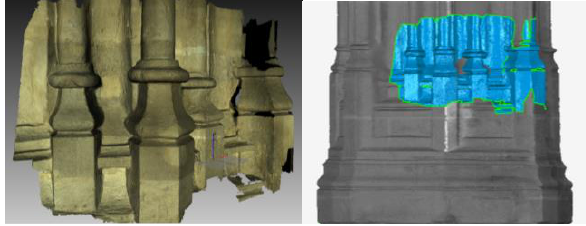
Figure 1. OS mesh placed on TLS point cloud (Church of Santiago)